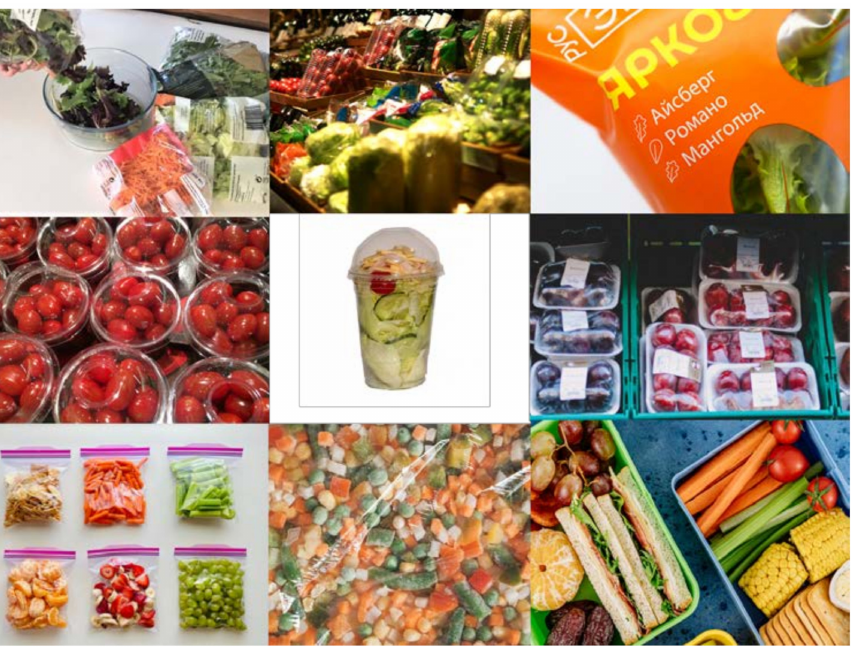
Figure 1. Examples of minimally processed (ready-to-eat) fruits and